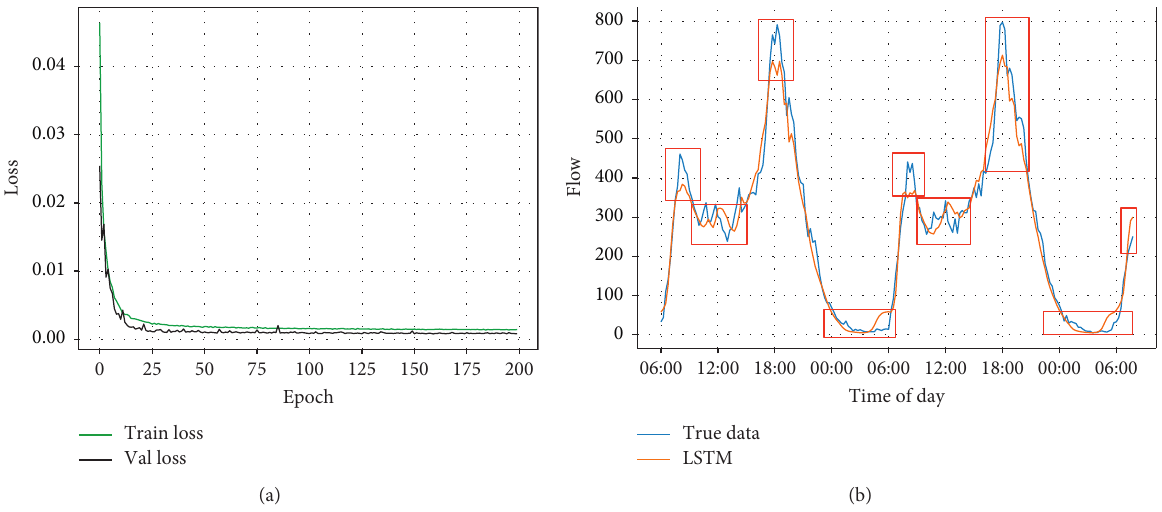
Figure 12: 20 steps LSTM training and prediction. (a) 20 steps LSTM loss function and (b) 20 steps LSTM prediction